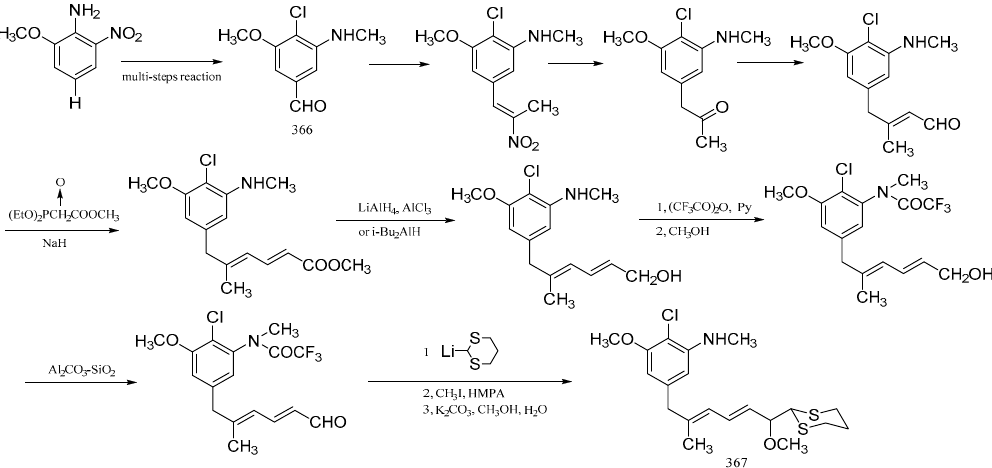
Figure 22. Synthesis of the derivatives from the C9-N fragment of maytansine.